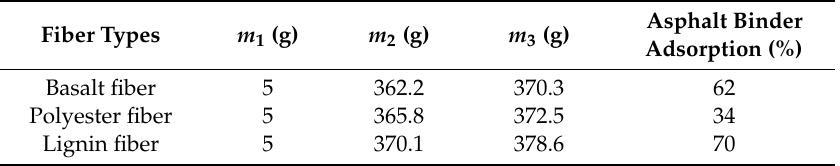
Table 8. Asphalt binder adsorption for three kinds of